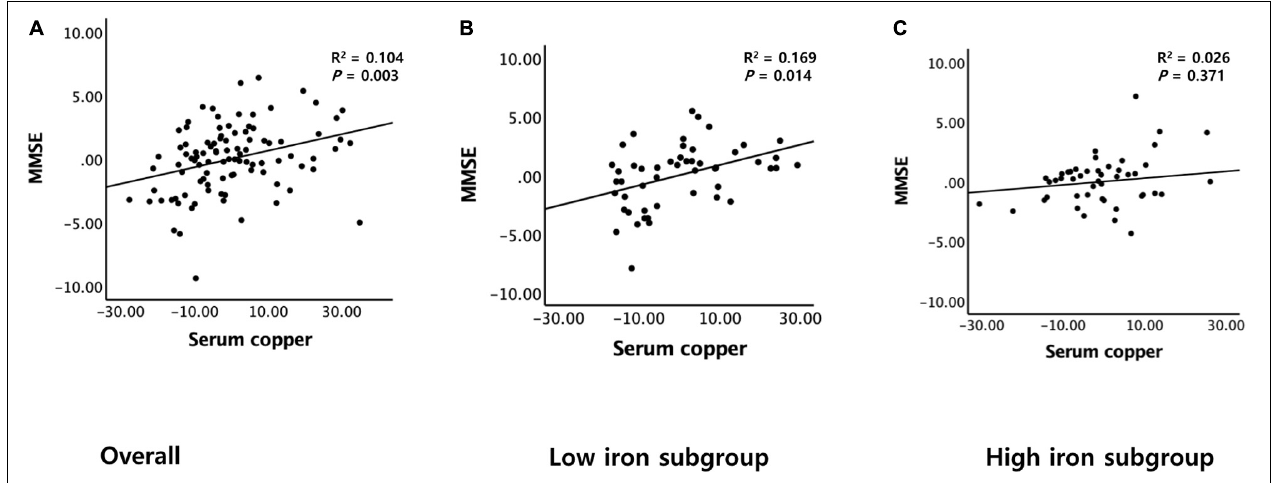
FIGURE 1 | Partial regression plots of the serum copper and MMSE score. (A) Overall and (B,C) by subgroup ( B , low iron and C , high iron). Multiple linear regression analyses were performed after adjusting for all confounders.